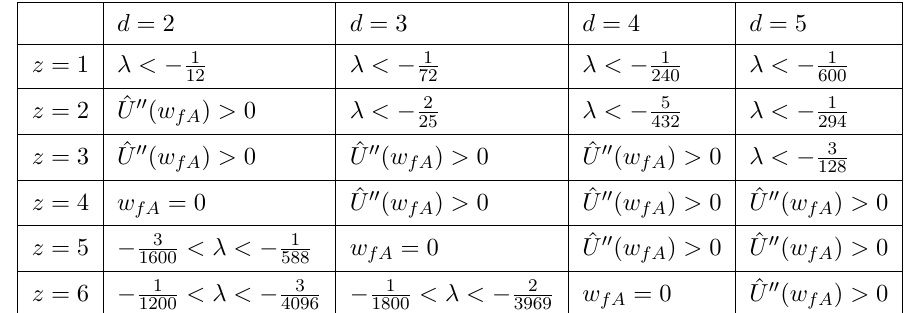
) > 0 . In these cases, w is a fA 1 fA 1